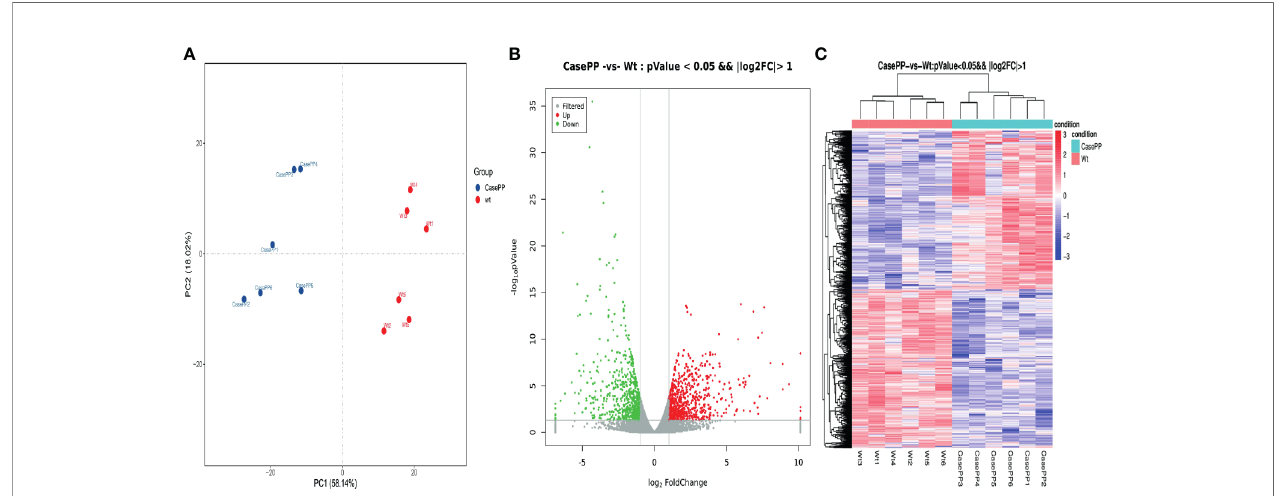
FIGURE 1 | Differentially expressed genes (DEGs) identi fi ed in PBMCs stimulated with PPE57 relative to control cells. (A) Principal component analysis of DEG transcripts. (B) A volcano plot highlighting DEGs in comparisons of control and PPE57-stimulated samples (log 10 p-value vs log 2 FC). Green and red dots with negative and positive change values respectively correspond to downregulated and upregulated DEGs. (C) Hierarchical clustering of transcripts that were signi fi cantly ( ≥ 2-fold change) upregulated (red) or downregulated (blue) in PPE57-treated PBMCs, with three repeats per sample.